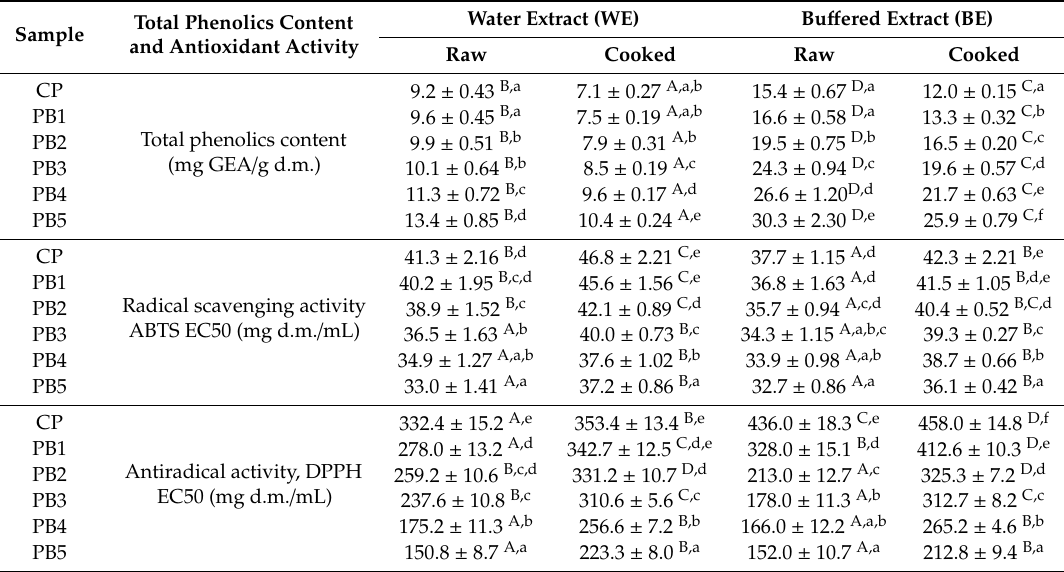
Table 4. TPC (total phenolics content) and antioxidant activities of raw and cooked pasta.